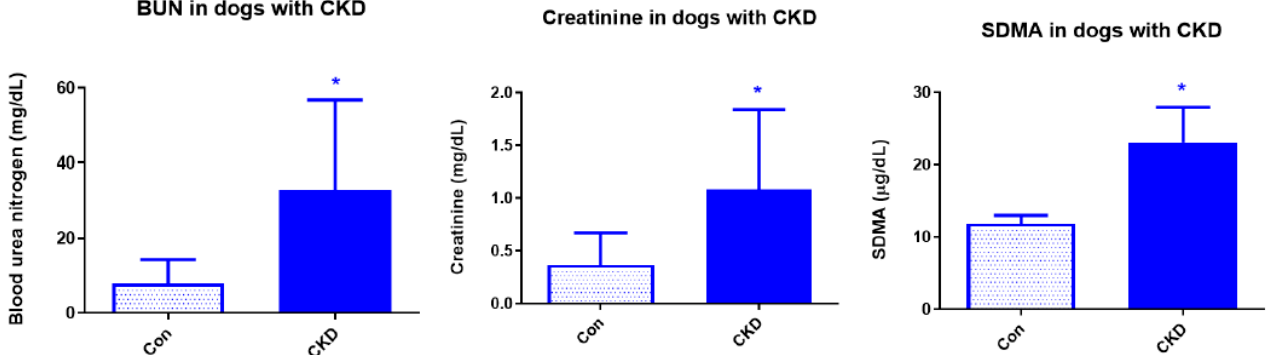
Figure 1. Circulating levels of kidney dysfunction. Increased levels of circulating biomarkers of renal dysfunction including creatinine, blood urea nitrogen (BUN), and symmetric dimethylarginine (SDMA) as assessed in the end-of-life samples. Data are presented as Mean ± SEM and BUN and creatinine ( n = 10 Con; n = 10 CKD; * p < 0.05). For SDMA the data are also presented as Mean ± SEM but n = 5 (Con) and n = 4 (CKD; * p <